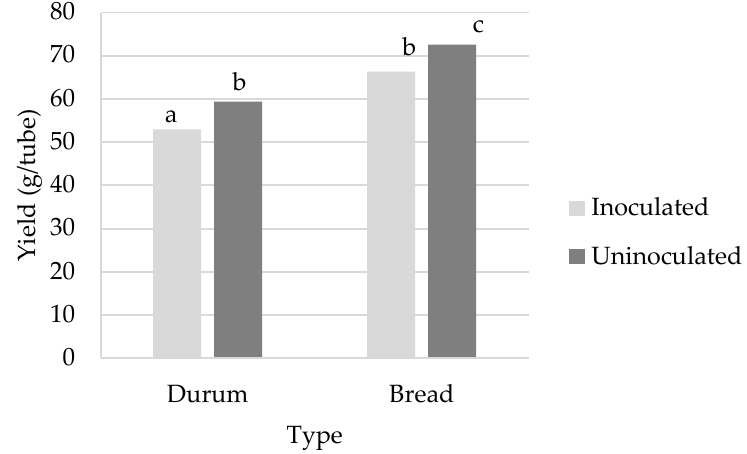
Figure 2. Grain yield per tube of 4 wheat cultivars as summarized by cereal type (two durum varieties: DBA Lillaroi and EGA Bellaroi and two bread varieties: LRPB Lancer and LRPB Flanker) in experiment exploring effect of FCR (inoculated and uninoculated) and variety. Bars with different letters indicate significant differences, p < 0.05.